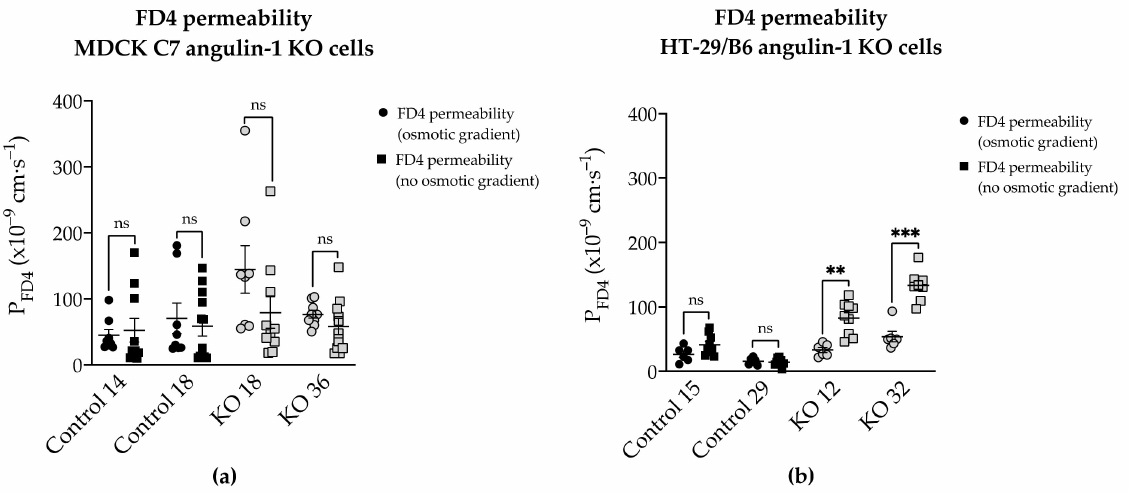
Figure 9. Comparison of angulin-1 knockout effect on permeability for 4-kDa FITC-dextran (FD4) under isosmotic and osmotic gradient conditions in ( a ) MDCK C7 and ( b ) HT-29/B6 cells. The FD4 permeability was higher under an isosmotic condition than under an osmotic gradient in angulin-1 KO HT-29/B6 cells, whereas no differences were observed in angulin-1 KO MDCK C7 cells. (ns: not significant, ** p ≤ 0.01, *** p ≤